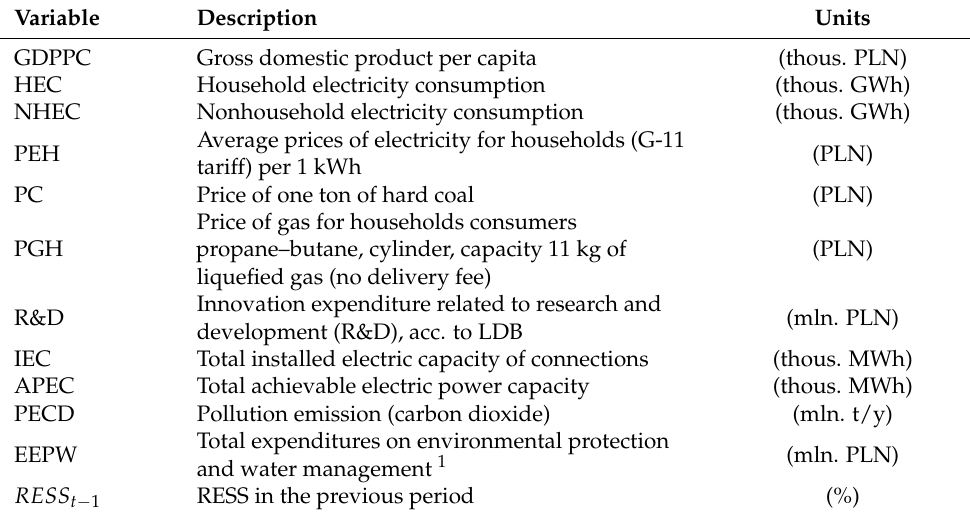
Table 2. Variables used in the